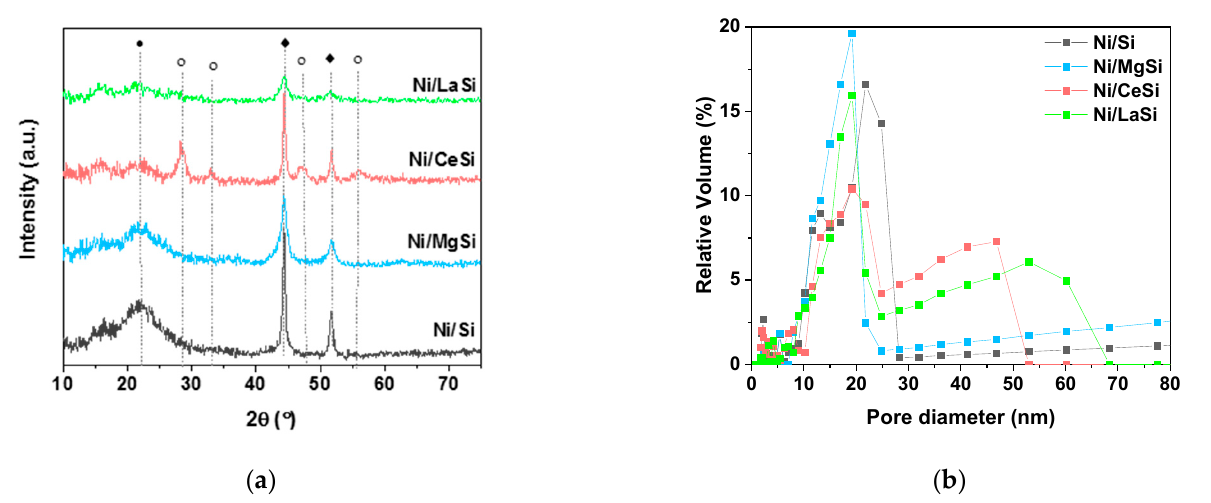
Figure 9. ( a ) XRD patterns of the Ni/Oxide-SiO 2 catalysts used in CO 2 methanation stability tests at 250 °C; ( ♦ ) peaks correspond to Ni; ( • ) peak corresponds to SiO 2 ; (o) peaks correspond to CeO 2 ; ( b ) pore size distribution for used catalysts. Table 3. The characteristics of catalysts used in the CO 2 methanation reaction (6h TOS).